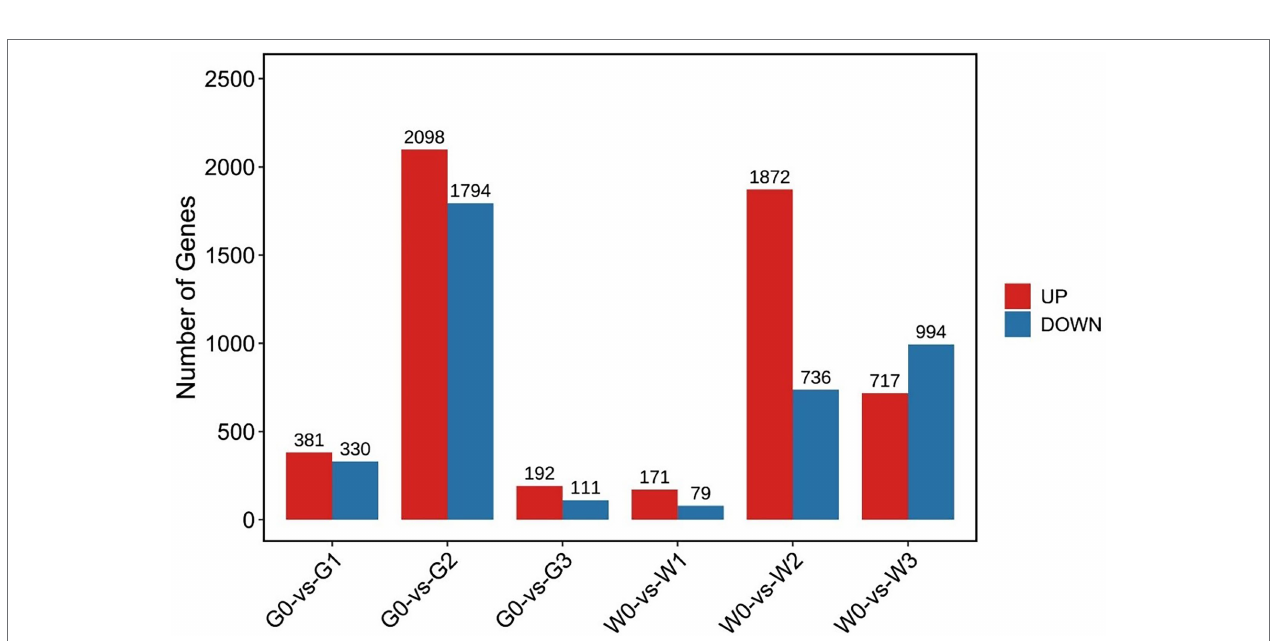
FIGURE 3 | Number of differentially expressed genes, either upregulated and downregulated, in alfalfa leaves following exposure to freezing stress. G0, G1, G2, and G3 represent the samples of “Gannong NO.3” exposed to freezing stress for 0, 0.5, 1, and 2 h, respectively. W0, W1, W2, and W3 represent the samples of “WL326GZ” exposed to freezing stress for 0, 0.5, 1, and 2 h,